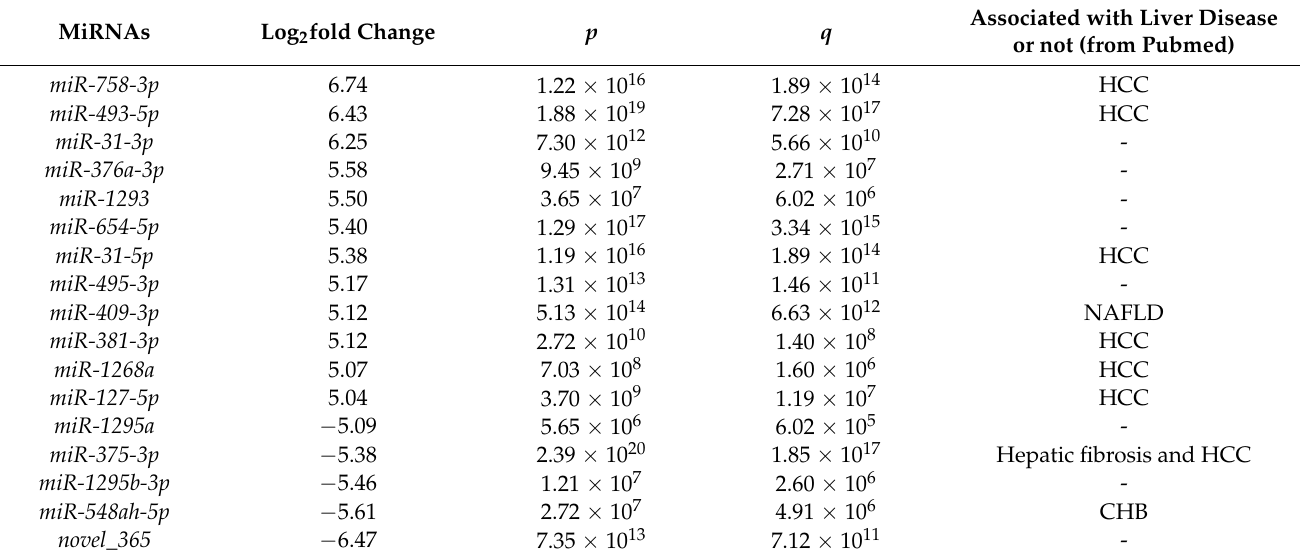
Table 1. DEmiRNAs in culture-activated HSCs versus freshly isolated HSCs (|log2fold change| > 5 and q <